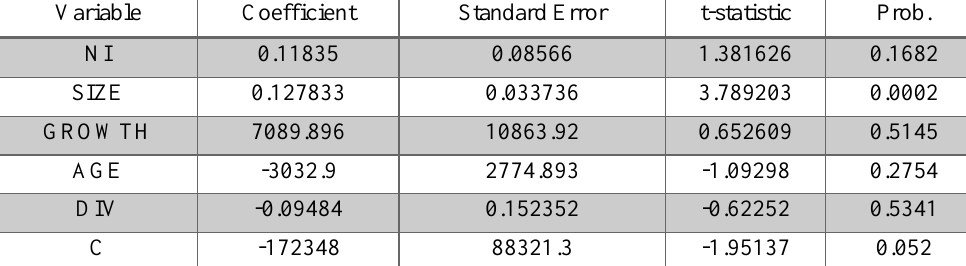
Table 9 . Results of fixed effects- Model Number 4